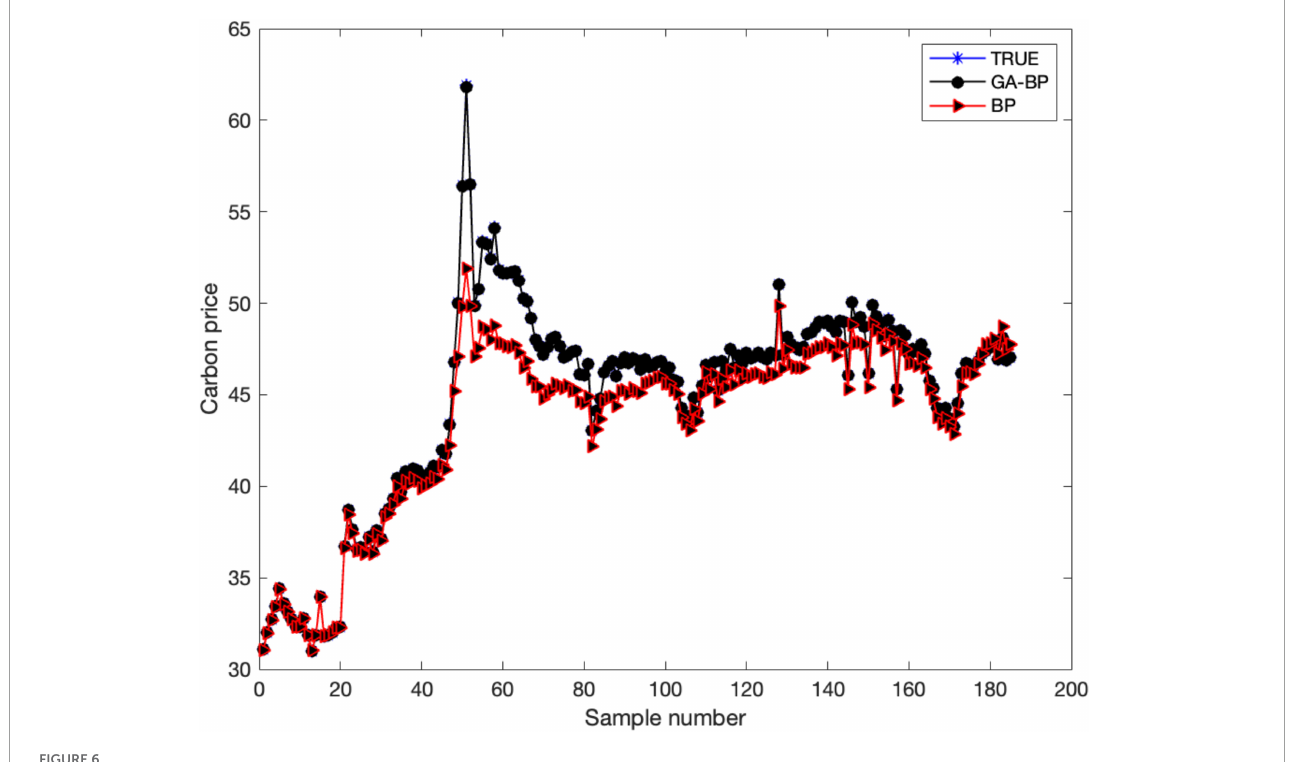
FIGURE6 GA-BP neural network simulation